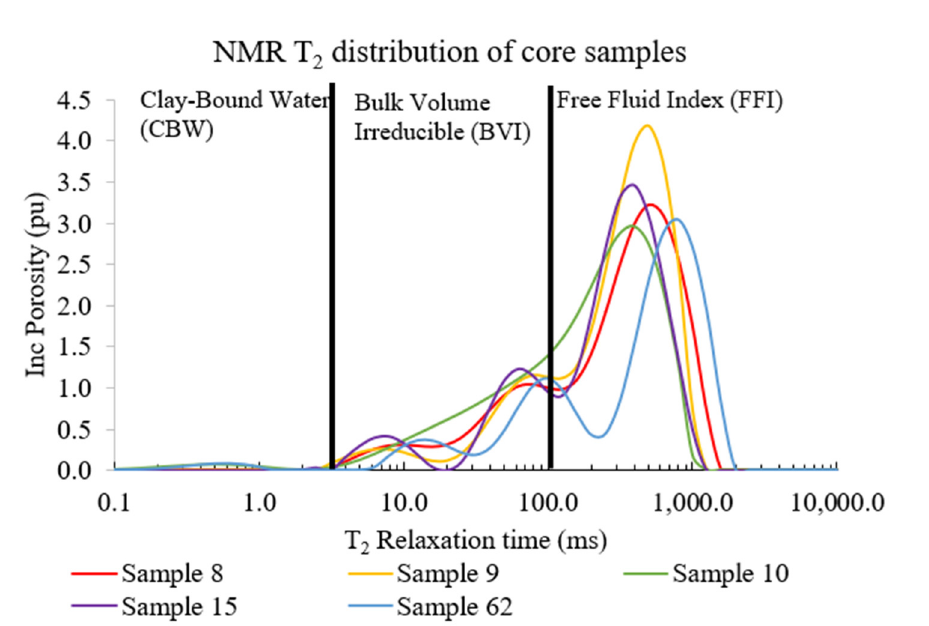
Figure 3. NMR T 2 multimodal pore size distribution of core samples at 100% water saturation.